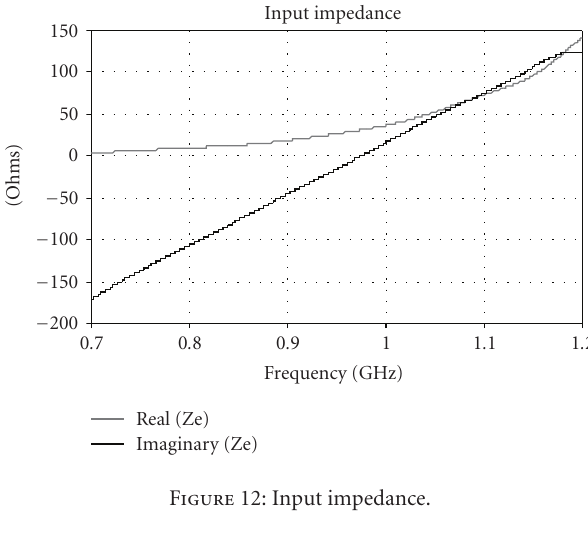
Figure 12: Input impedance.